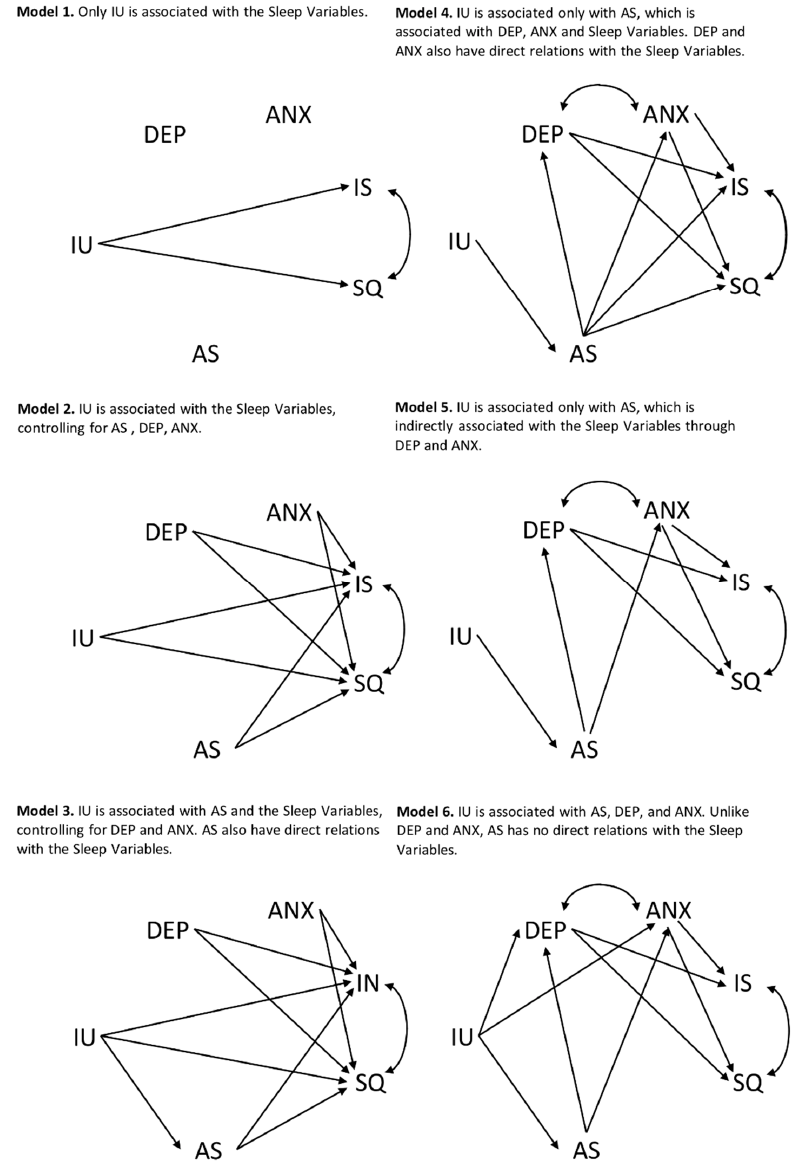
Figure 1. Schematic representation of six alternative structural equation models of sleep quality and insomnia severity. IU = Intolerance of Uncertainty; AS = Anxiety Sensitivity; DEP = Depression; ANX = Anxiety; IS = Insomnia Severity; SQ = Sleep Quality.